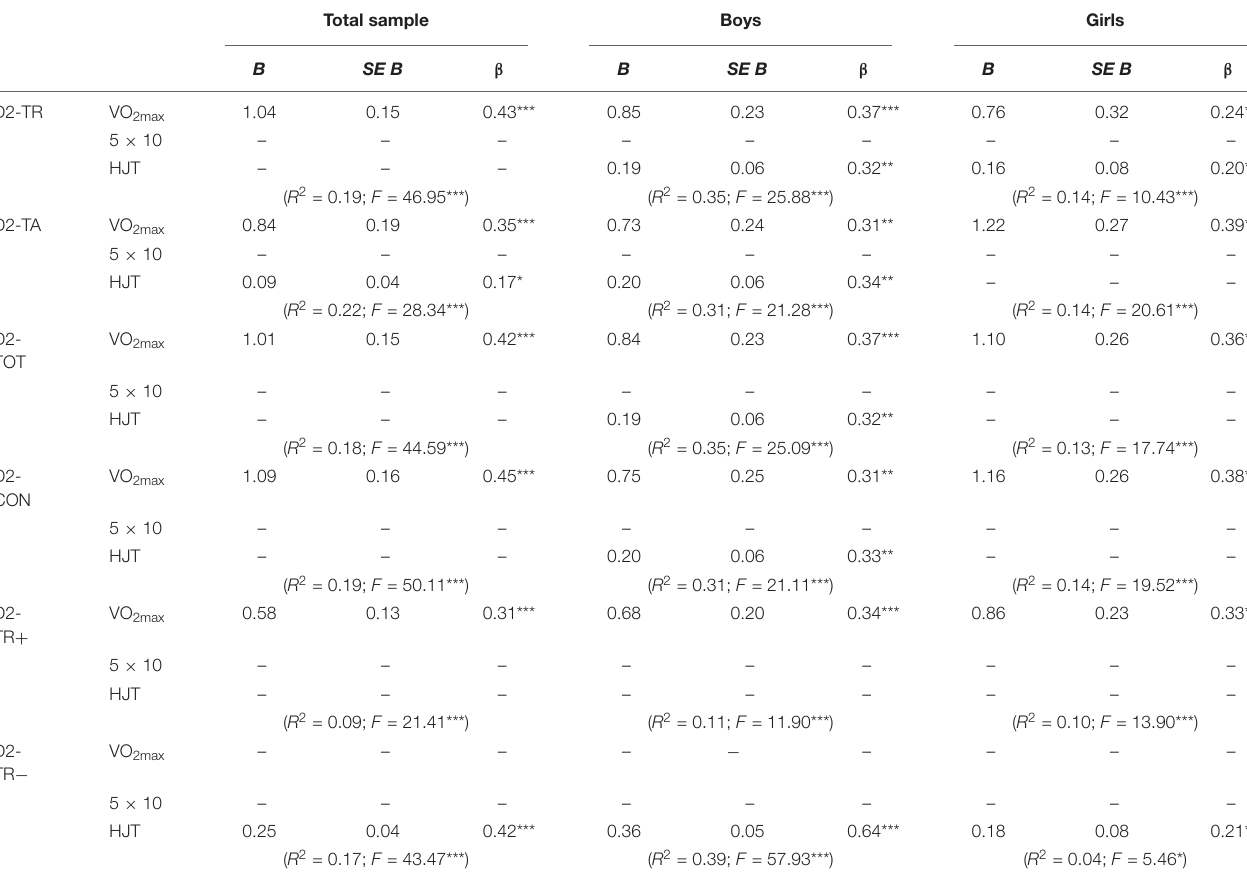
TABLE 3 | Linear regression analysis of D2 test factors regressed on physical fitness predictors by gender and total sample. Total